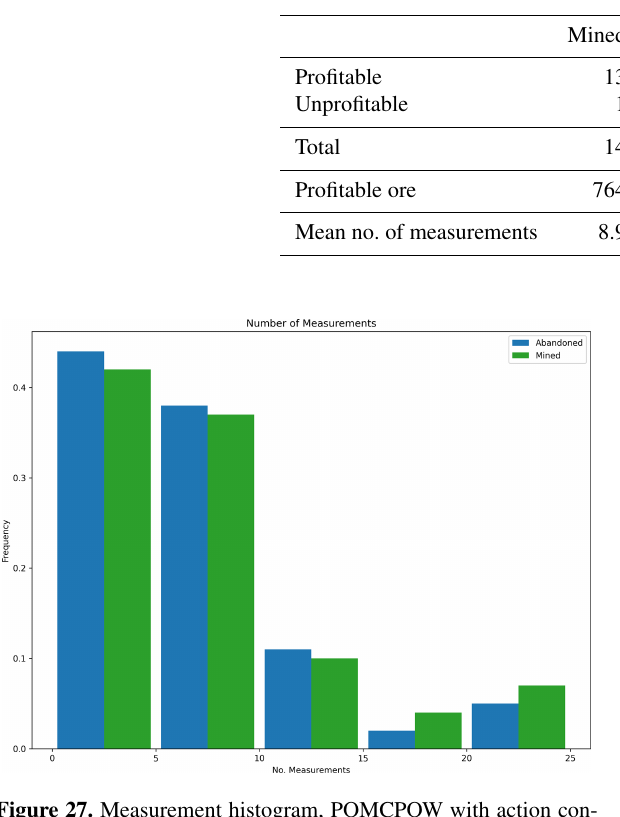
Figure 27. Measurement histogram, POMCPOW with action con- straints, multiple ore bodies. This figure shows a histogram of the number of measurements taken by the POMCPOW solver over all Monte Carlo trials. The trials were limited to a maximum of 25 measurements.